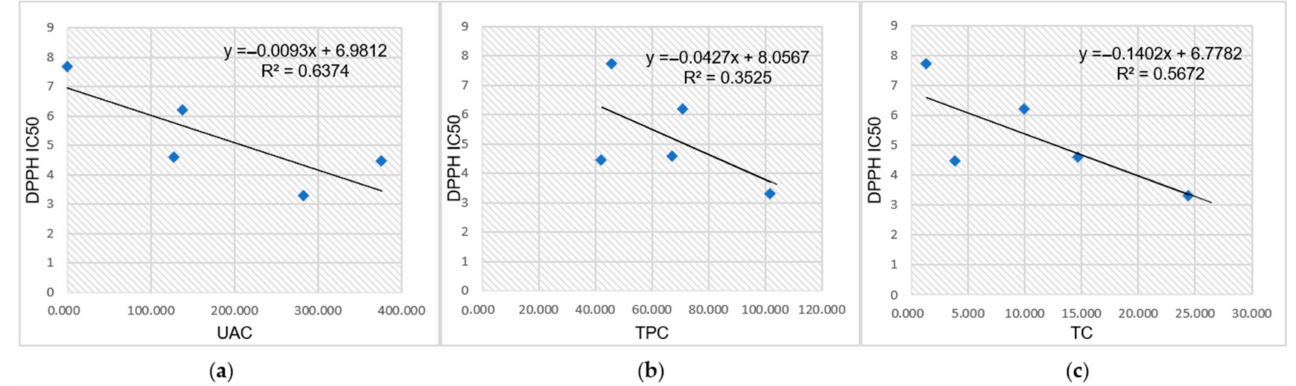
Figure 3. The correlation between UAC ( a ), TPC ( b ), TC ( c ), and AA (expressed by DPPH IC 50 ) of UBDE.